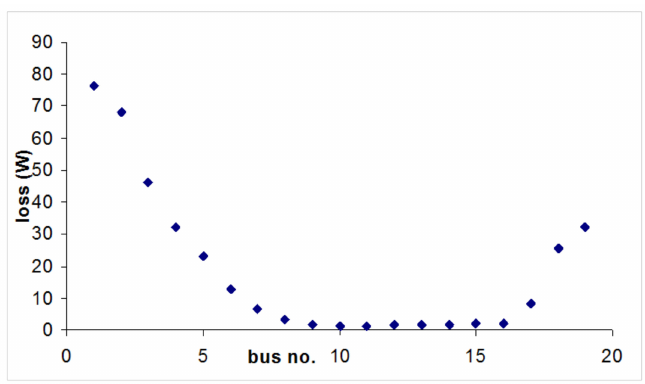
Figure 20. Variation of losses with location of PV system in the Rajmachi system.